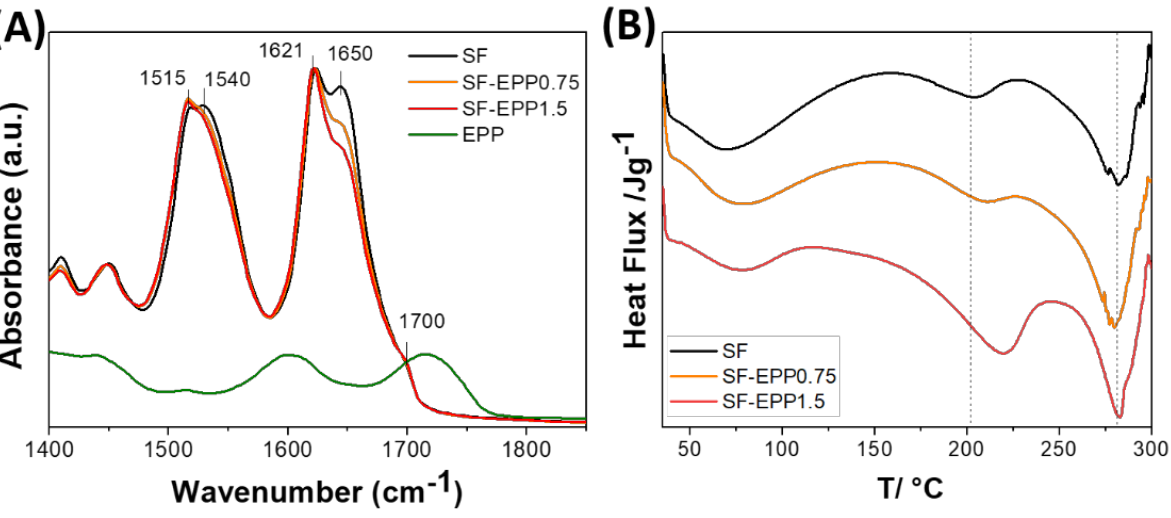
Figure 3. ( A ) FTIR spectra of pristine SF (black line), SF-EPP0.75 (orange line) and SFEPP1.5 (red line) films and EPP (olive line) in the 1400–1900 cm − 1 range. ( B ) DSC curves of SF (black line), SF-EPP0.75 (orange line) and SF-EPP1.5 (red line) films.